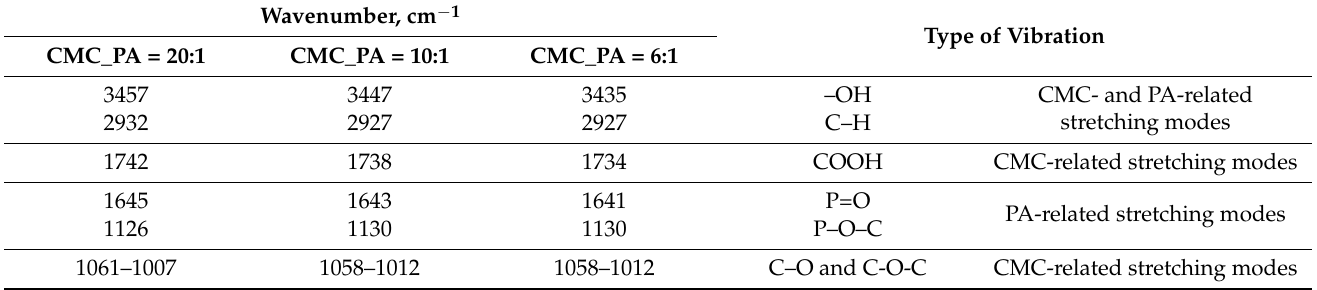
Table 1. FTIR characteristic bands and their assignment for the studied